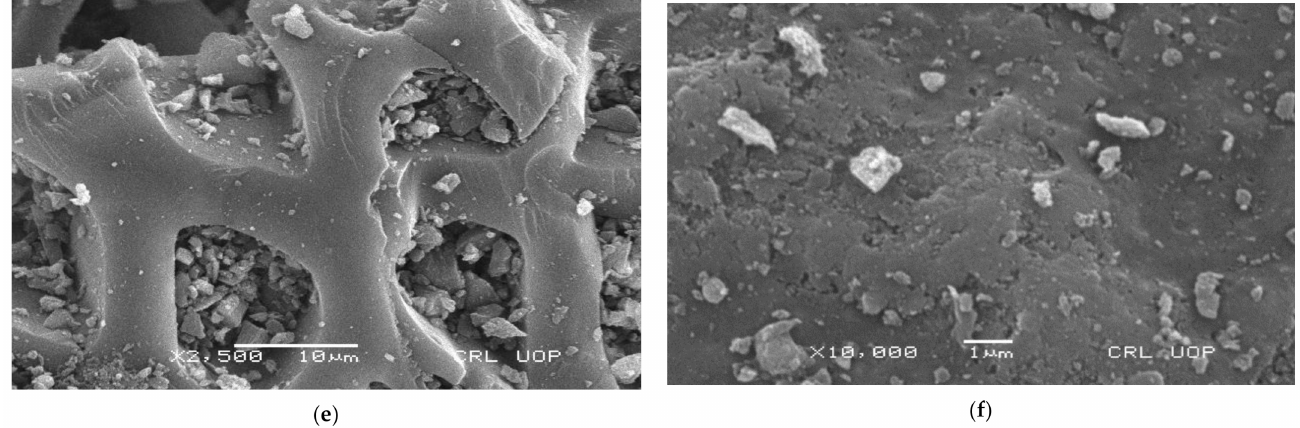
Figure 4. SEM images of prepared AC under various resolutions and magnifications: ( a ) 100 × ( b ) 230 × ( c ) 500 × ( d ) 1000 × ( e ) 2500 × and ( f ) 10,000 × magnifications.